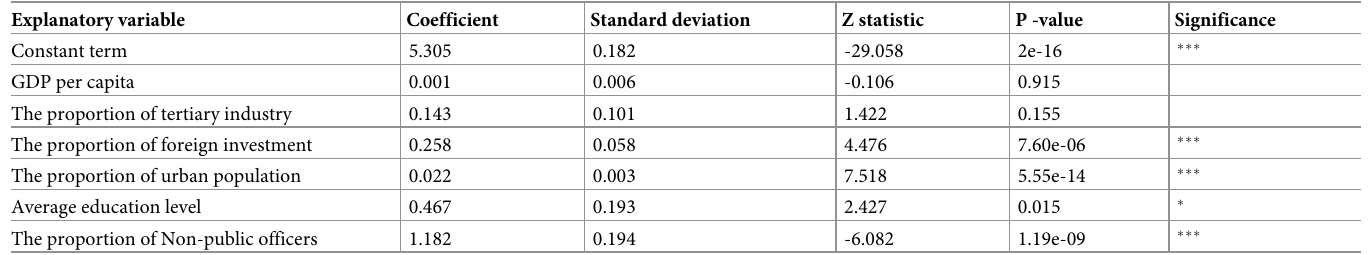
Table 8. Tobit regression analysis of factors influencing